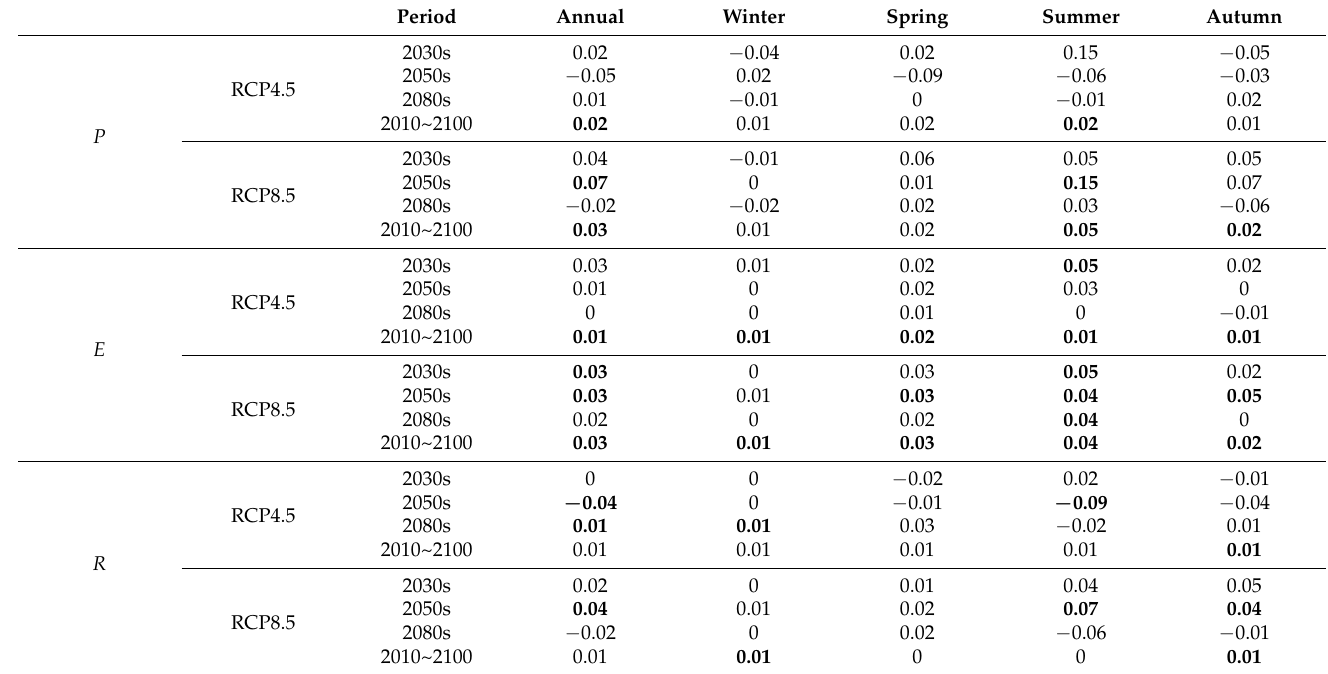
Table 2. Future trends (mm/day per decade) of domain average precipitation, evapotranspiration, and runoff ( P , E , and R denote precipitation, evapotranspiration, and runoff,